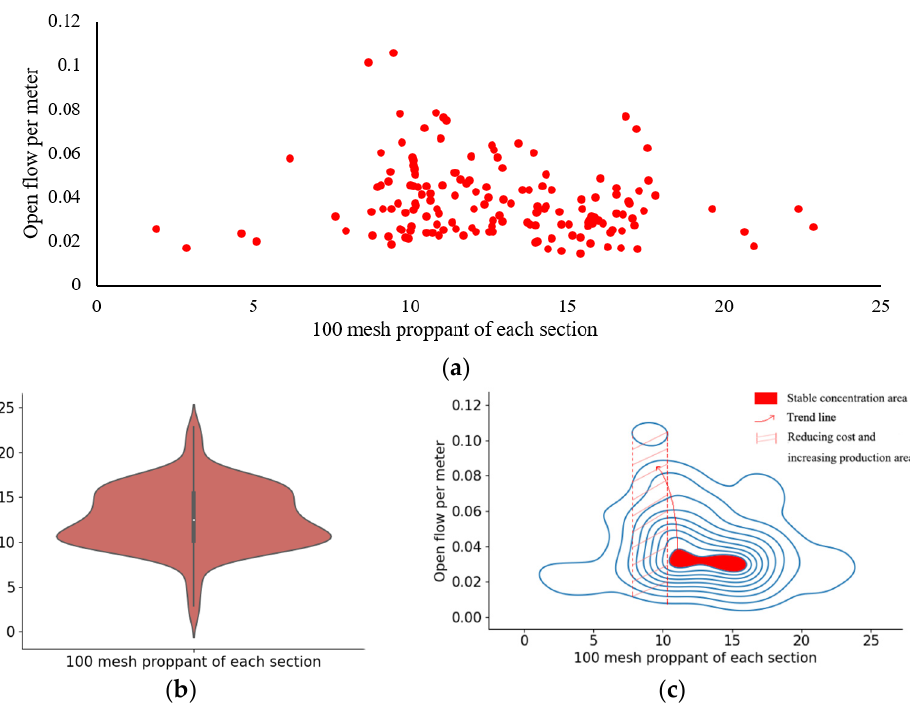
Figure 7. Analysis of 100 mesh proppant data. ( a ) Scatter plot of 100 mesh proppant; ( b ) violin plot of 100 mesh proppant; ( c ) binary KDE plot of 100 mesh proppant.